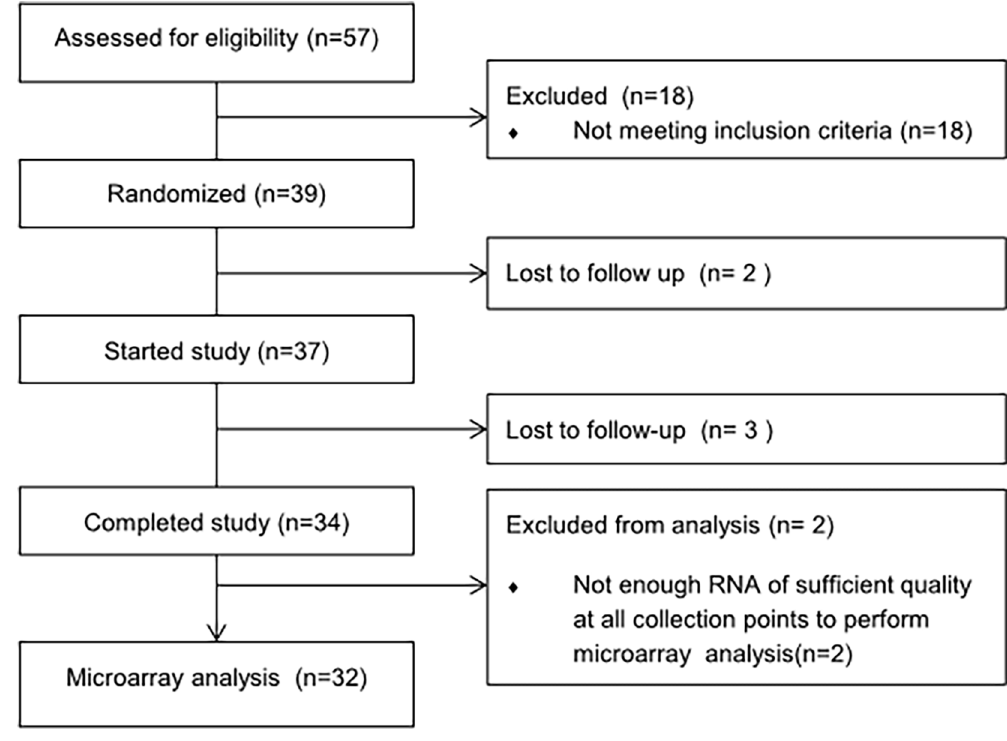
Fig 1. CONSORT flow